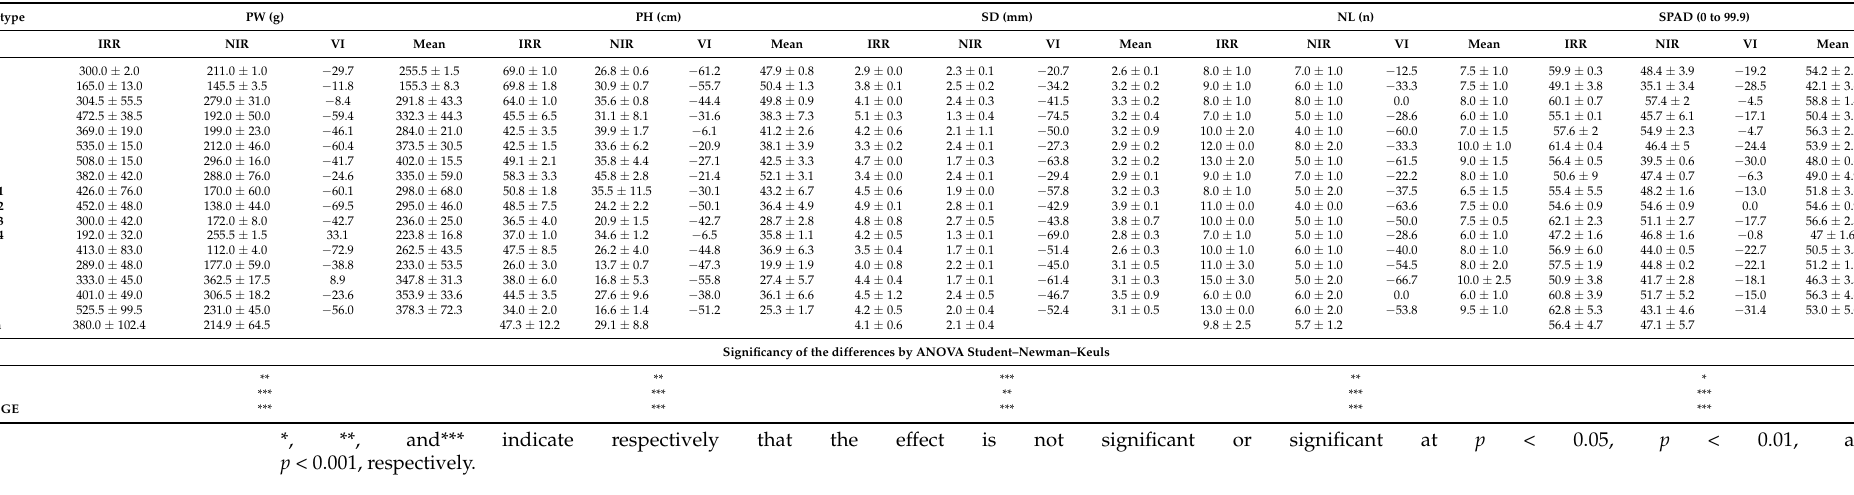
Table 2. Variation in the plant weight (PW), height (PH), stem diameter (SD), number of leaves (NL), leaves SPAD index, and the variation index (VI) in relation to the experimental factors